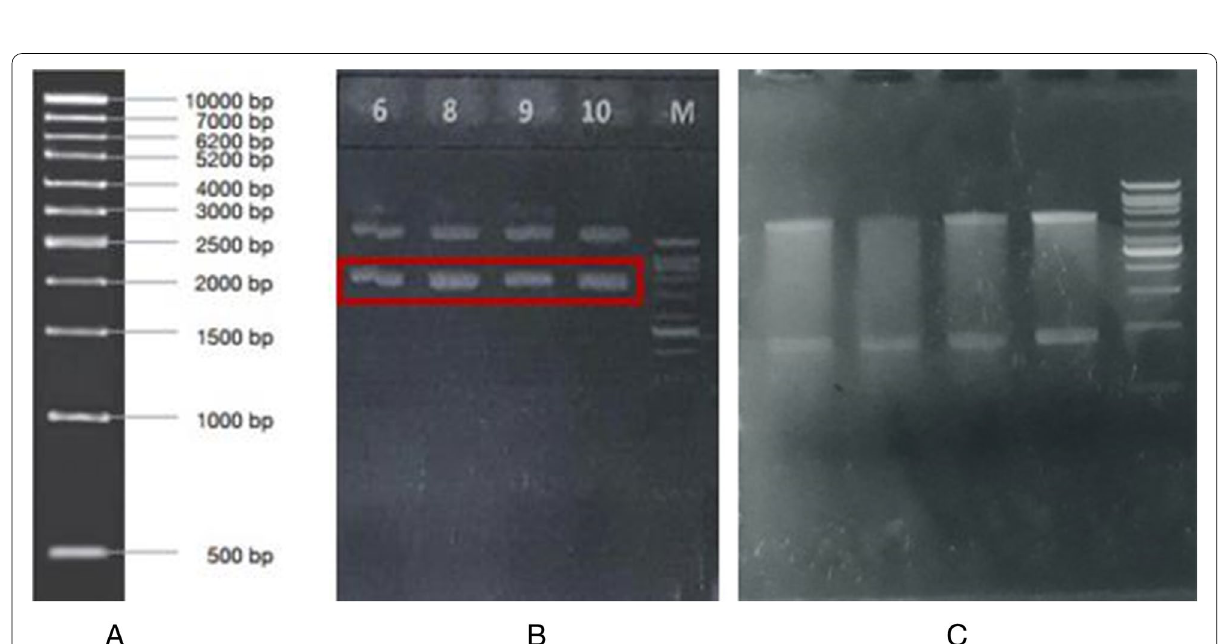
Fig. 2 Electrophoregram of plasmid isolation and digestion as a part of transformants selection step in E. coli Mach1 ™ -T1 R harboring pD451-MR_ L1-HPV52. The DNA bands were compared to 1kb DNA ladder and code numbers 6, 8, 9, 10 represent colonies number 6, 8, 9, and 10. M: DNA Ladder 1kb (Vivantis); A : size of 1 kb DNA marker; B : uncut plasmid, which demonstrates 2 types of DNA bands, nicked and supercoiled; C : plasmid digestion using 2 digestion enzymes, Eco RI and Xba I, presentation of 2 DNA bands are well defined at 4507 and 933